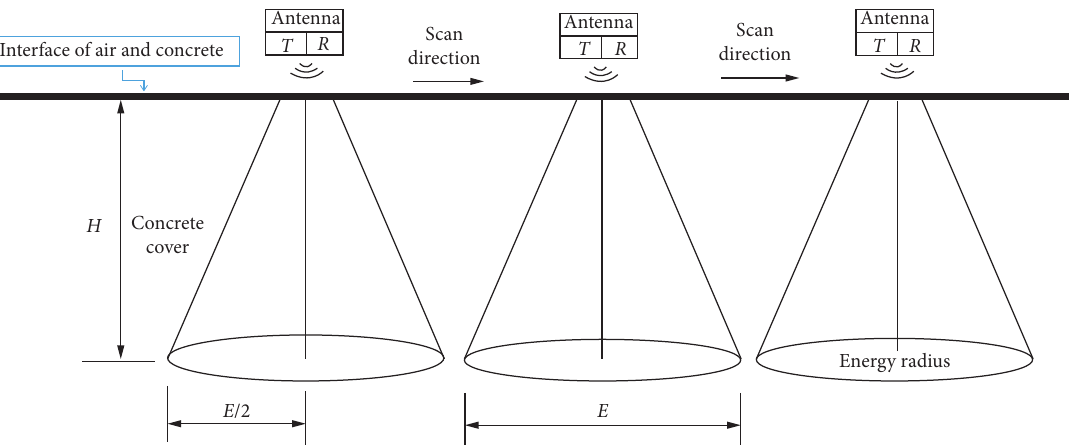
Figure 2: The elliptical cone of GPR waves propagating into the inspecting medium. Note: T, transmitting antenna; R, receiving antenna; E, energy diameter; E/2, energy radius; H, thickness of concrete